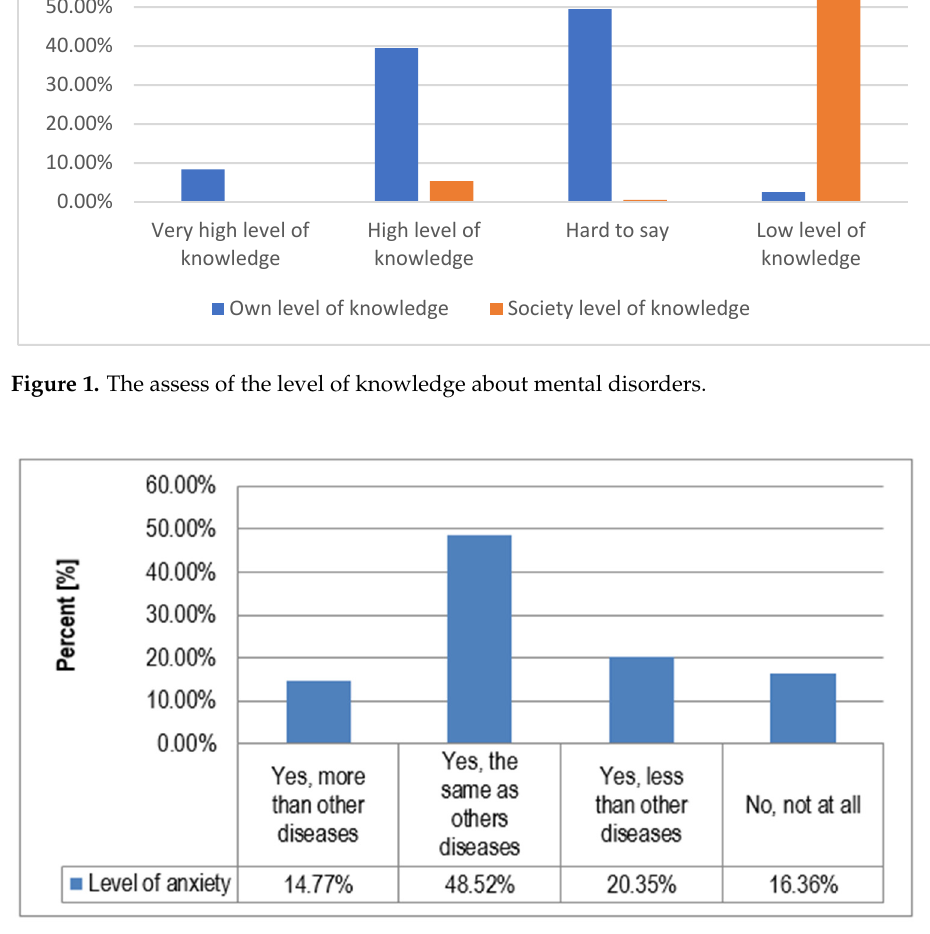
Figure 2. How do you rate your level of knowledge about mental disorders.